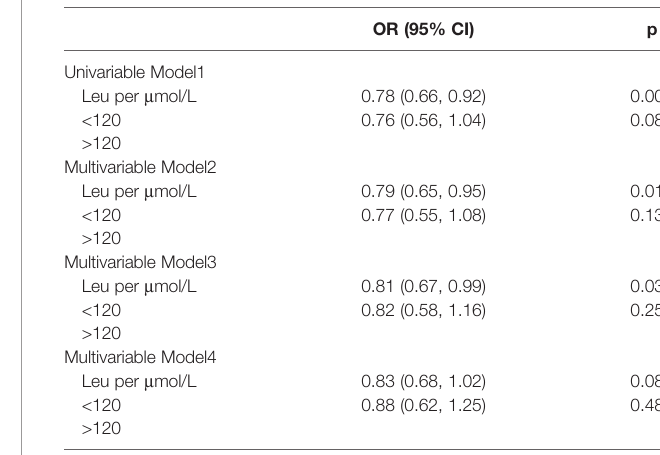
TABLE 2 | Risk OR of leu and DR under multiple